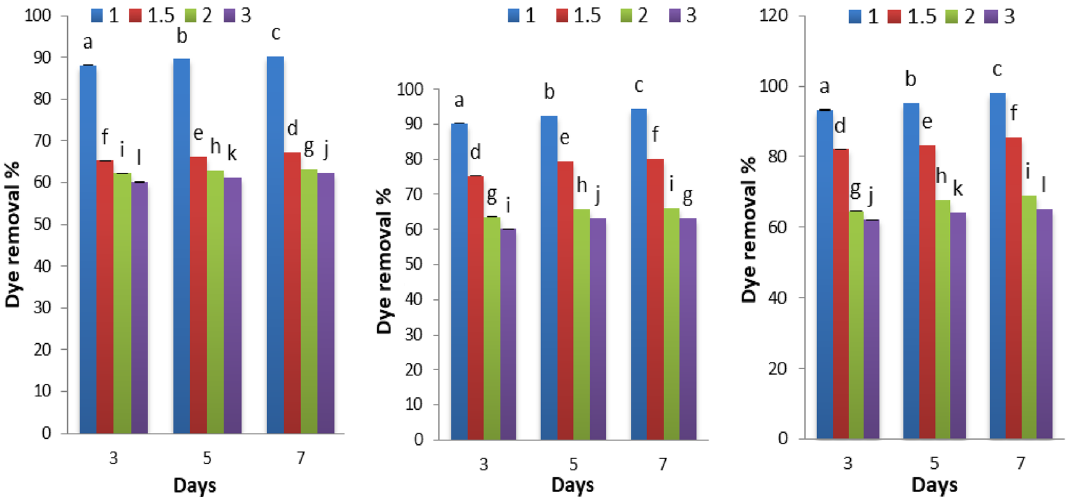
Figure 4. Effect of different nitrogen concentrations on the of Disperse orange 2RL (20 ppm) removal percentage by microgreen alga S. obliquus grown under mixotrophic ( a ), heterotrophic ( b ), heterotrophic supplemented with glucose ( c ). Par represent standard error, different letters clear the significant result.